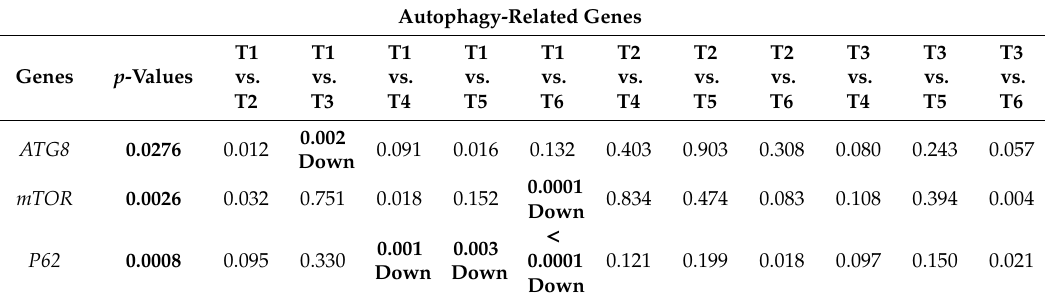
Table 8. Di ff erentially expressed autophagy-related genes.